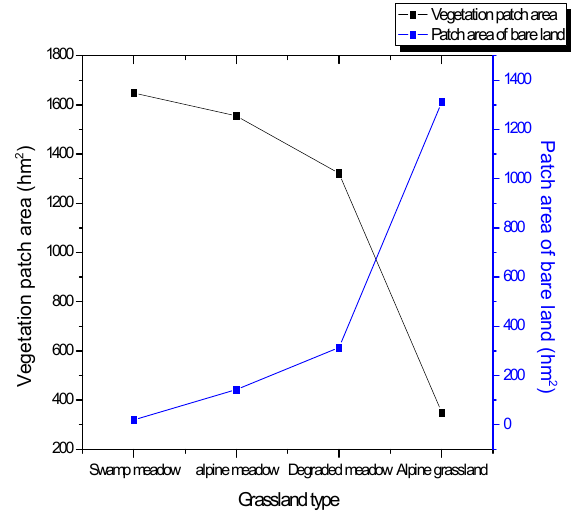
Figure 4. Area curves of four grassland patch